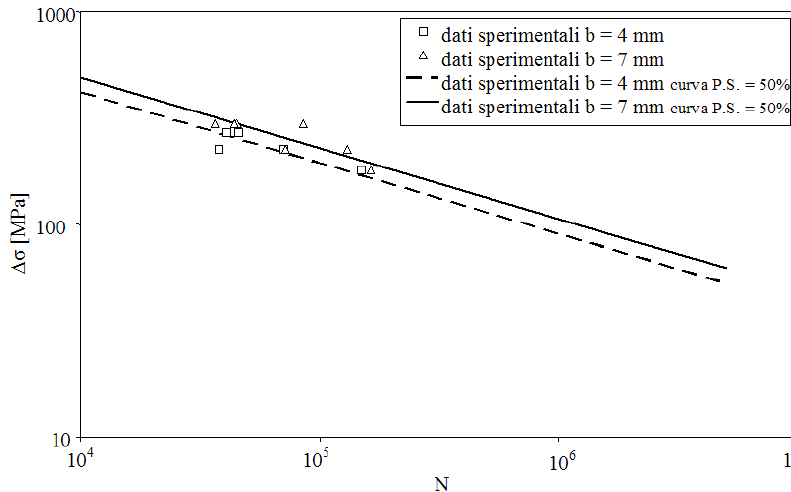
Figura 5: Risultati delle prove di